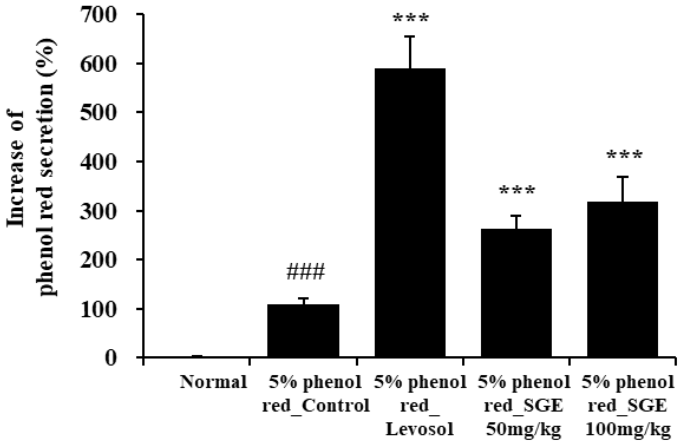
Figure 8. Effect of SGE on phenol red secretion in ICR mice. The amount of phenol red secretion in the airways was measured by injecting 5% phenol red into mice treated with Levosol or SGE for 3 days. The data are presented as means ± SEM (n = 10 mice) for individual mice. ### p < 0.001 compared to the normal group, and *** p < 0.001 compared to the control group.